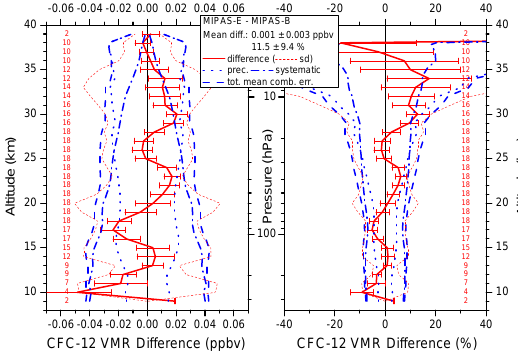
Figure 3: Same as Figure 1, but for the species CFC-11. A positive bias is visible in the MIPAS-E data, especially above 19 km.